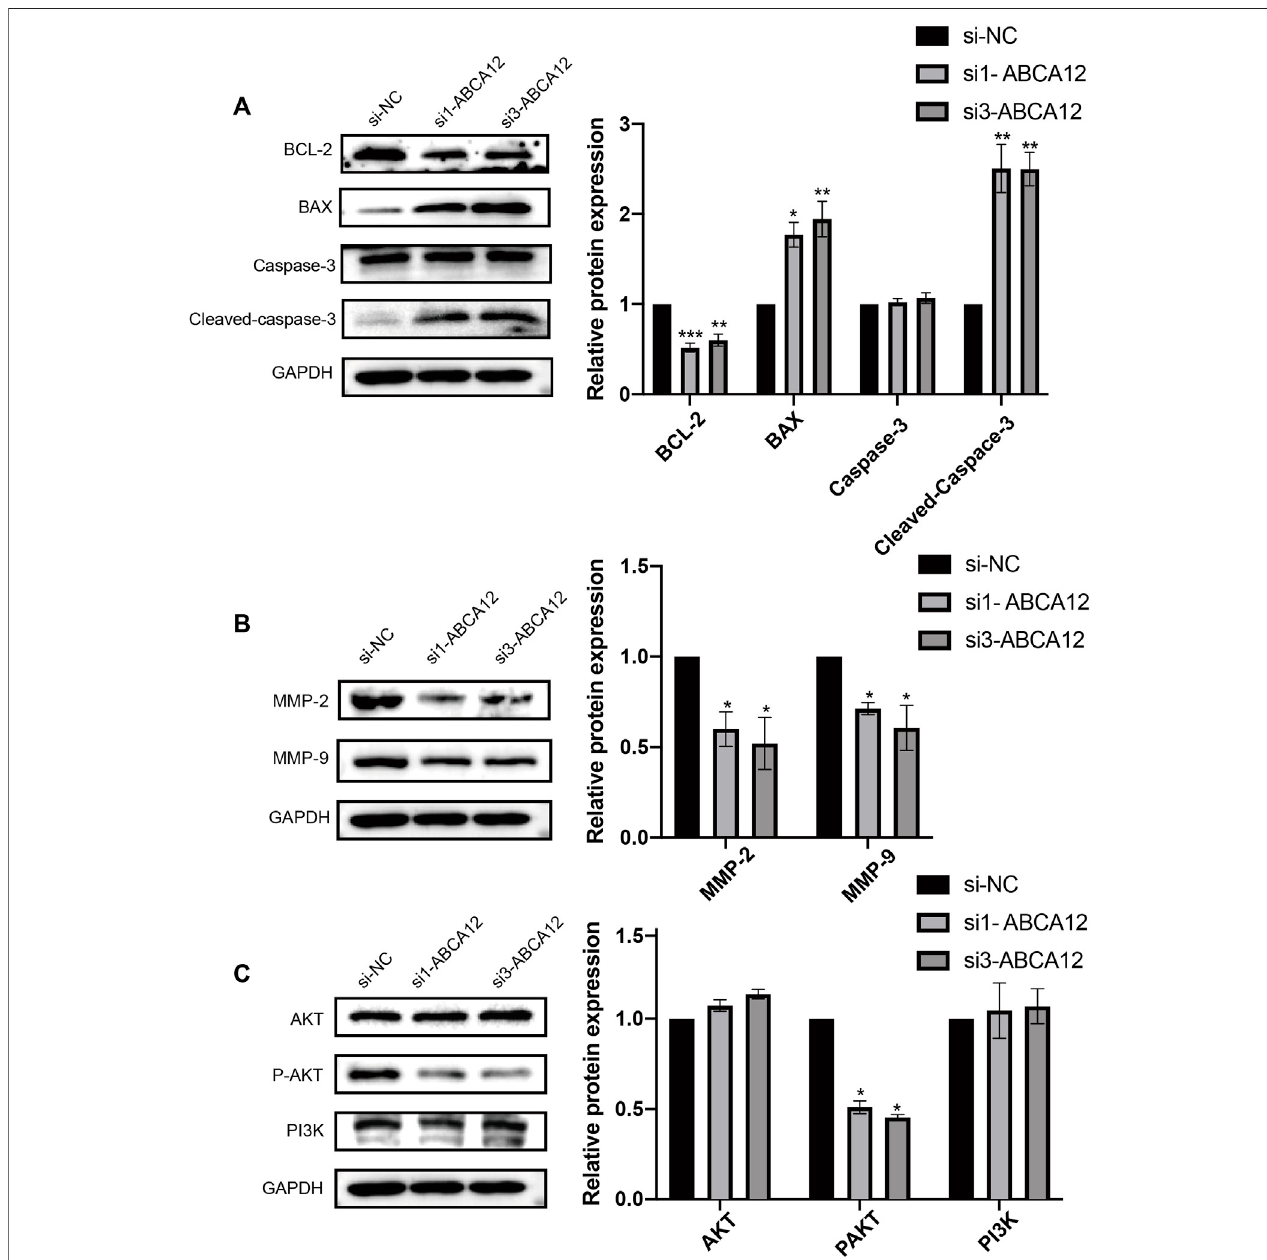
FIGURE6| Changesofapoptosis,migrationandpathwayproteinsinSW1990cellsafter ABCA12 knockdown. (A) After ABCA12 knockdown,theexpressionlevel of BCL2 protein was decreased, and BAX protein was increased. Cleaved caspase3 expression was decreased when caspase3 remained unchanged. (B) The expression of MMP-2 and MMP-9 was signi fi cantly decreased after ABCA12 knockout. (C) After ABCA12 inhibition, the expression of P-AKT decreased, while the expression of AKT and PI3K remained basically unchanged.